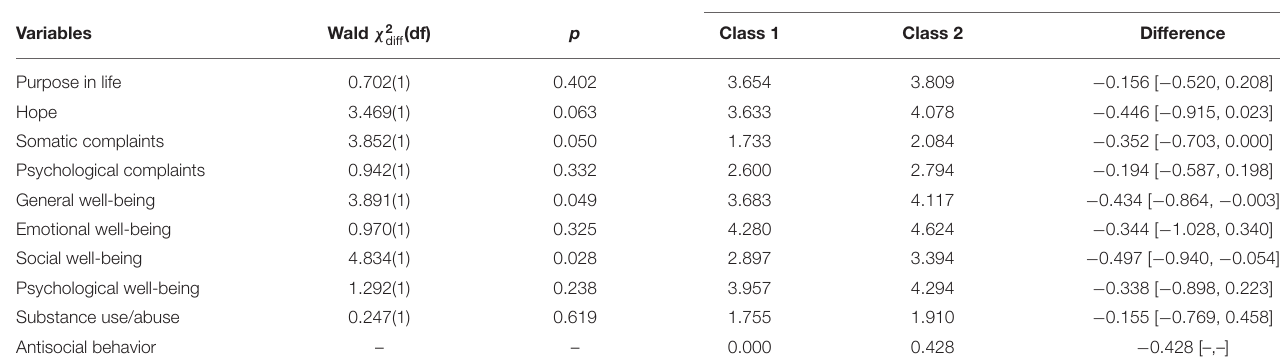
TABLE 3 | Difference tests, Class 1 vs. Class